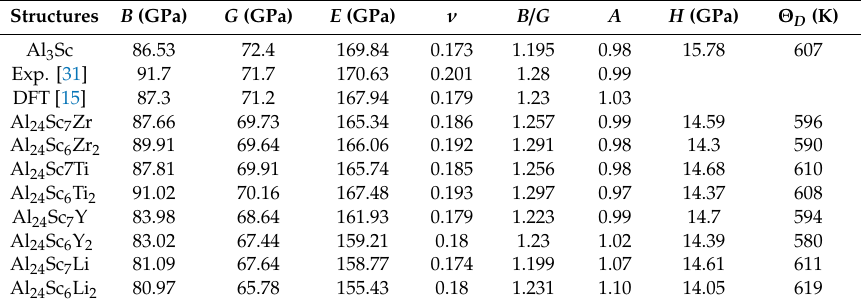
Table 3. Elastic moduli B , G , E , ν , B / G , H , A and Θ D for L1 2 -Al 3 Sc 1– x M x , at the ground state.